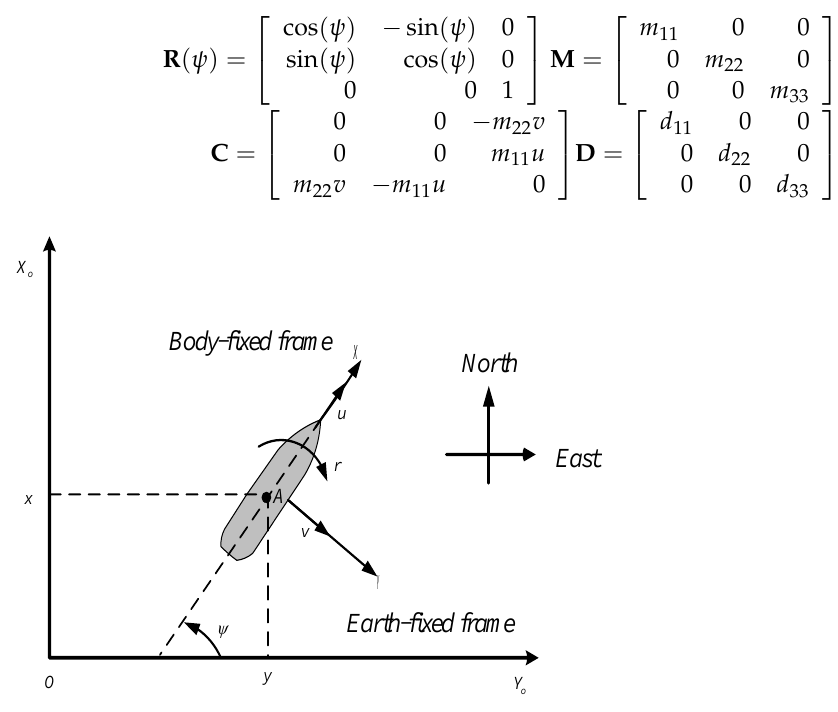
Figure 1. Earth-fixed O X Y − and body-fixed A X Y − coordinate frames of a USV.